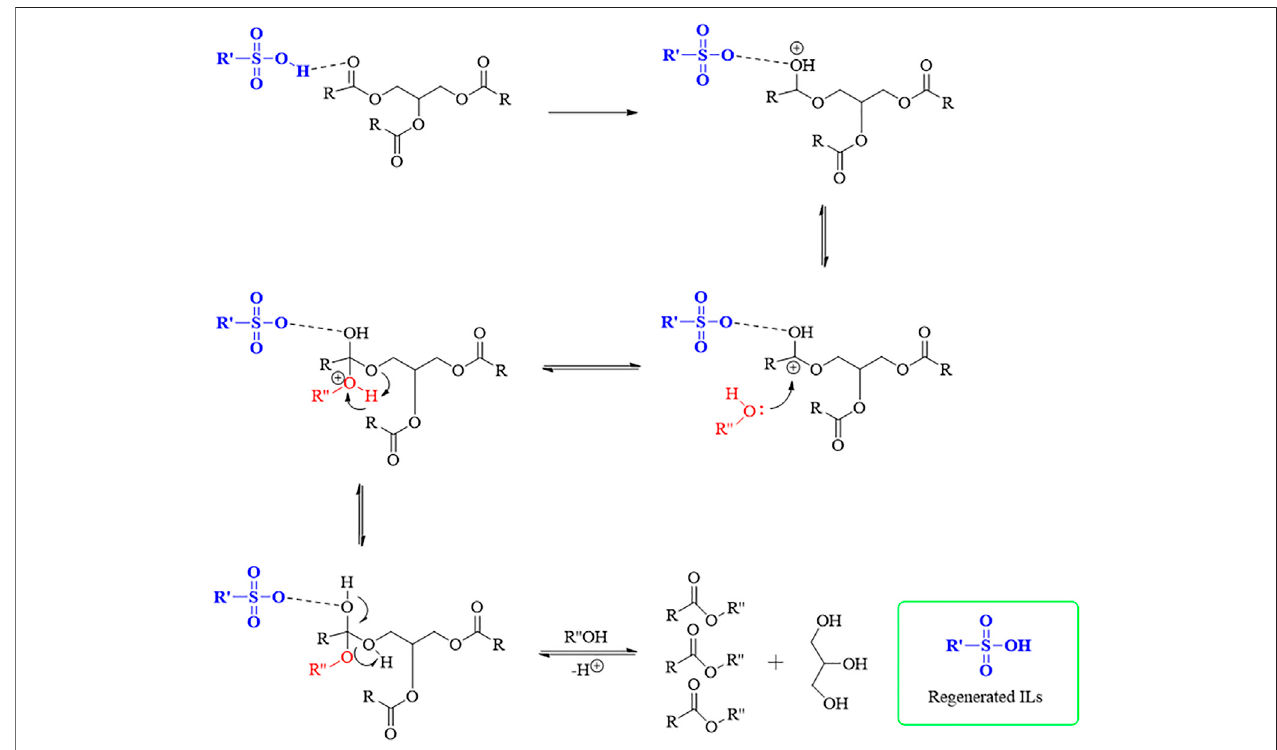
FIGURE1| Plausiblemechanismoftransesteri fi cationofmicroalgallipidswithalcoholusingsulfonicILscatalyst[Here,Rdenotesthealkylchainofthetriglycerides, R ′ denotes the struture of the ILs expert the -SO3H group and R ’’ denotes the alkyl group of alcohol].